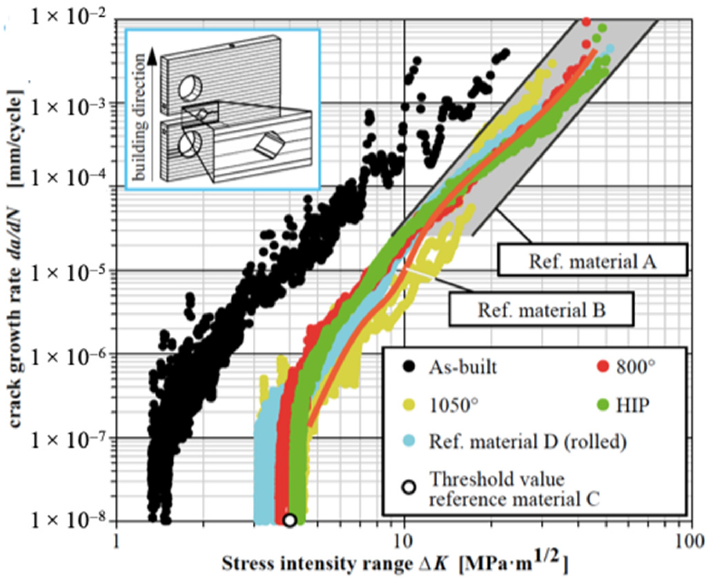
Figure 8. Fatigue crack growth data of Ti6Al4V by LPBF for different material conditions (building direction is normal to crack growth direction (reproduced with permission from [85]. Copyright 2016 Andre